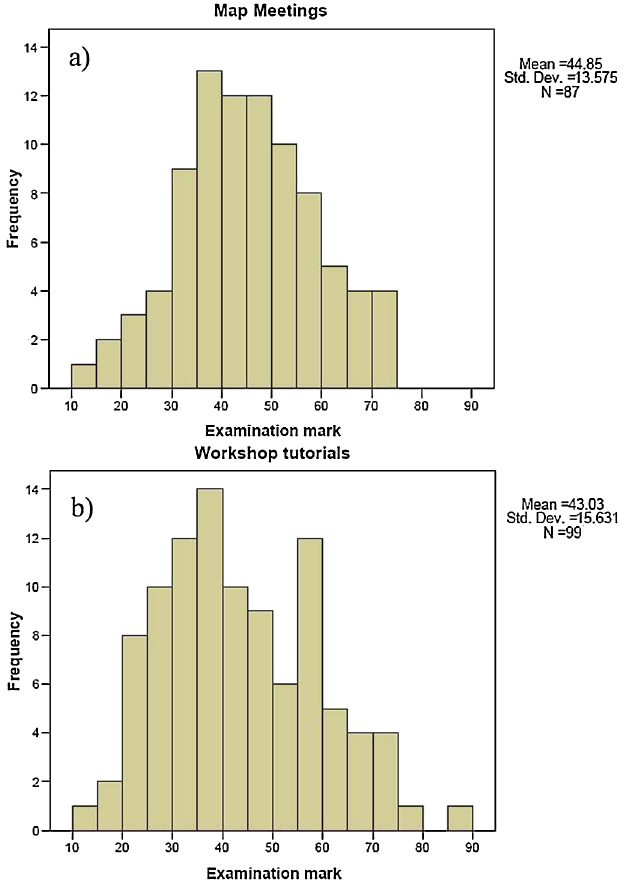
FIG. 5 (color online). Histograms of marks for all persistent students in Map Meetings (a) and Workshop Tutorials (b) in the end-of-semester examination. Note that each bin refers to the number of students who received from the lower mark inclusive to the upper mark